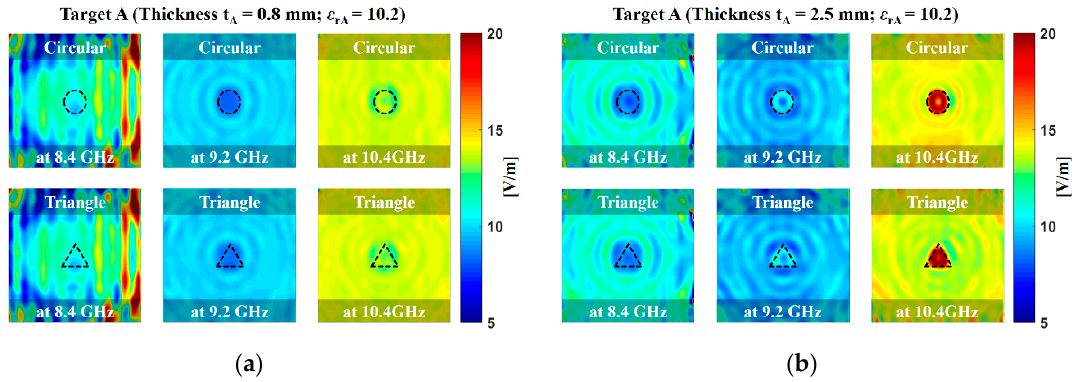
Figure 6. Measured microwave image of the target A with the thicknesses of ( a ) 0.8 mm and ( b ) 2.5 mm at scanning frequencies of 8.4 GHz, 9.2 GHz, and 10.4 GHz. Target A was a ceramic–polytetrafluoroethylene composite with a dielectric constant ( ε rA ) of 10.2. A total of 2601 frequency sampling points were extracted by using HP 8510C vector network analyzers (VNAs).